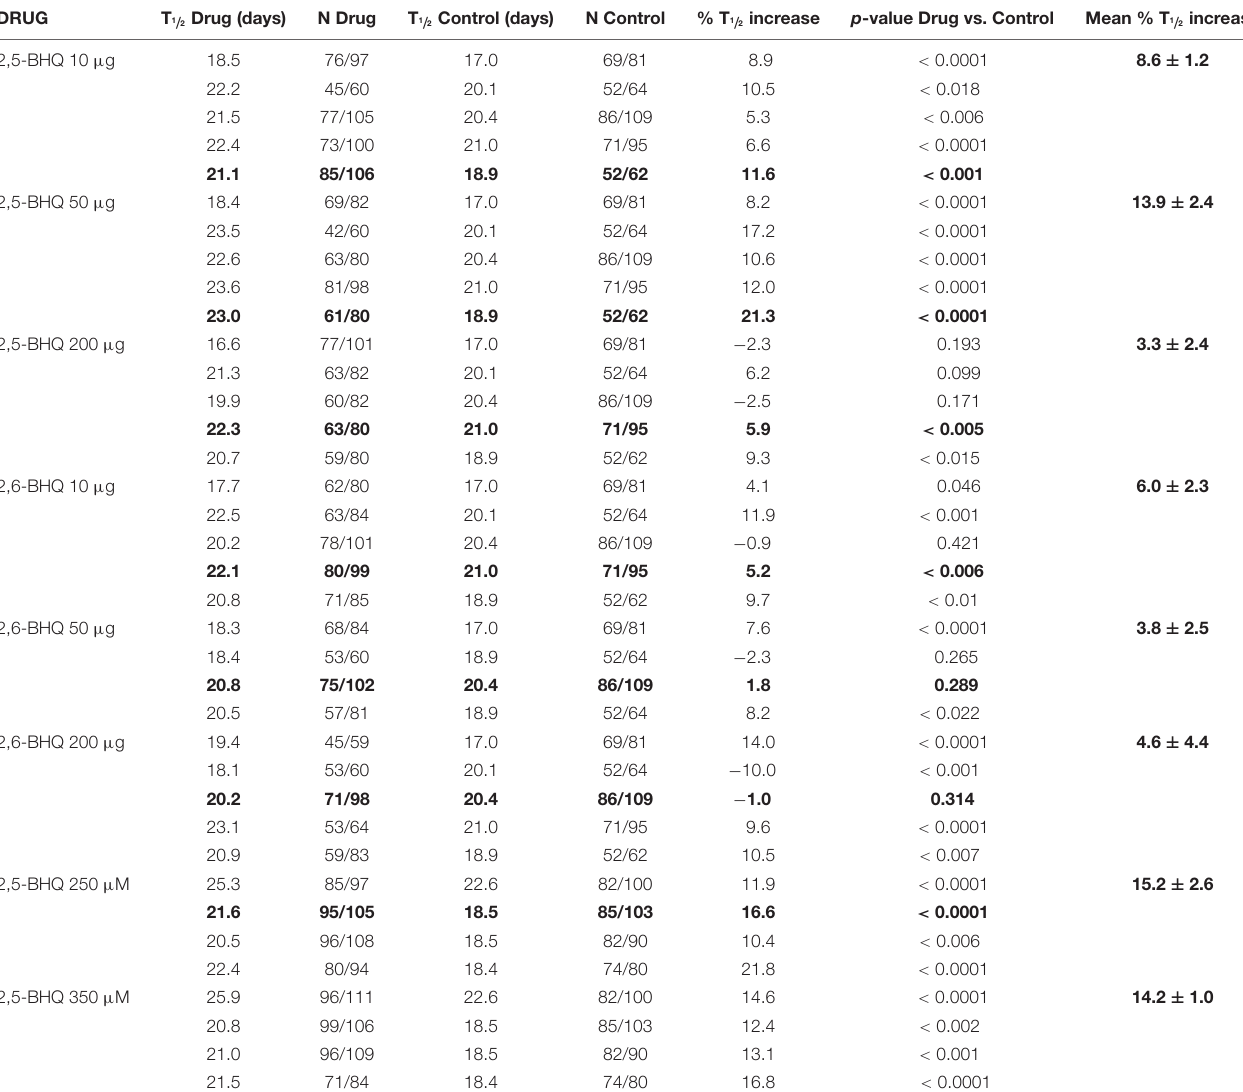
TABLE 1 | Lifespan assays performed with 2,5-BHQ and 2,6-BHQ in wild-type worms. DRUG T 1 / Drug 2